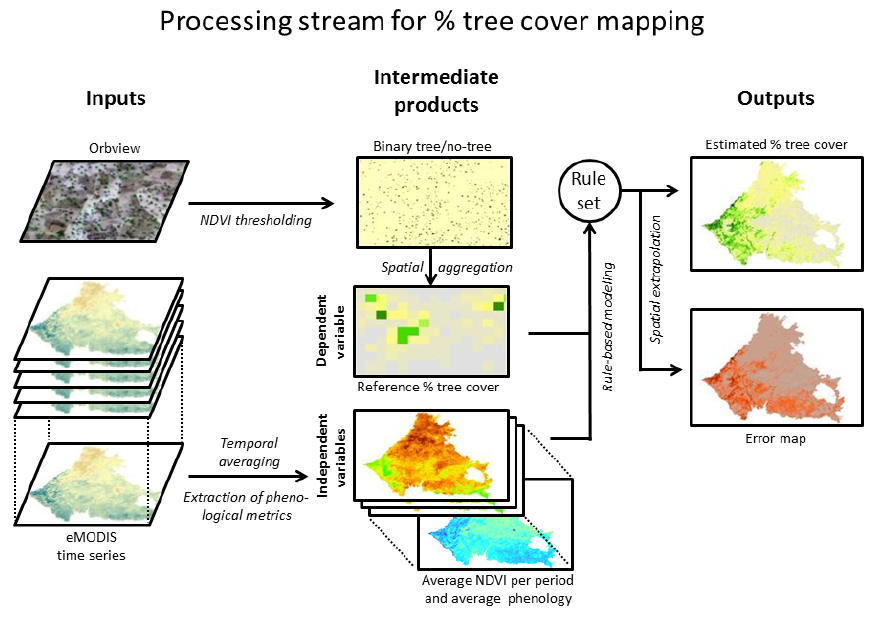
Figure 3. Illustrated diagram of the data processing stream leading to the estimated percent tree cover map of the study region. Cubist® was used to derive a set of decision rules from training cases, each of which is linked to a multiple linear regression